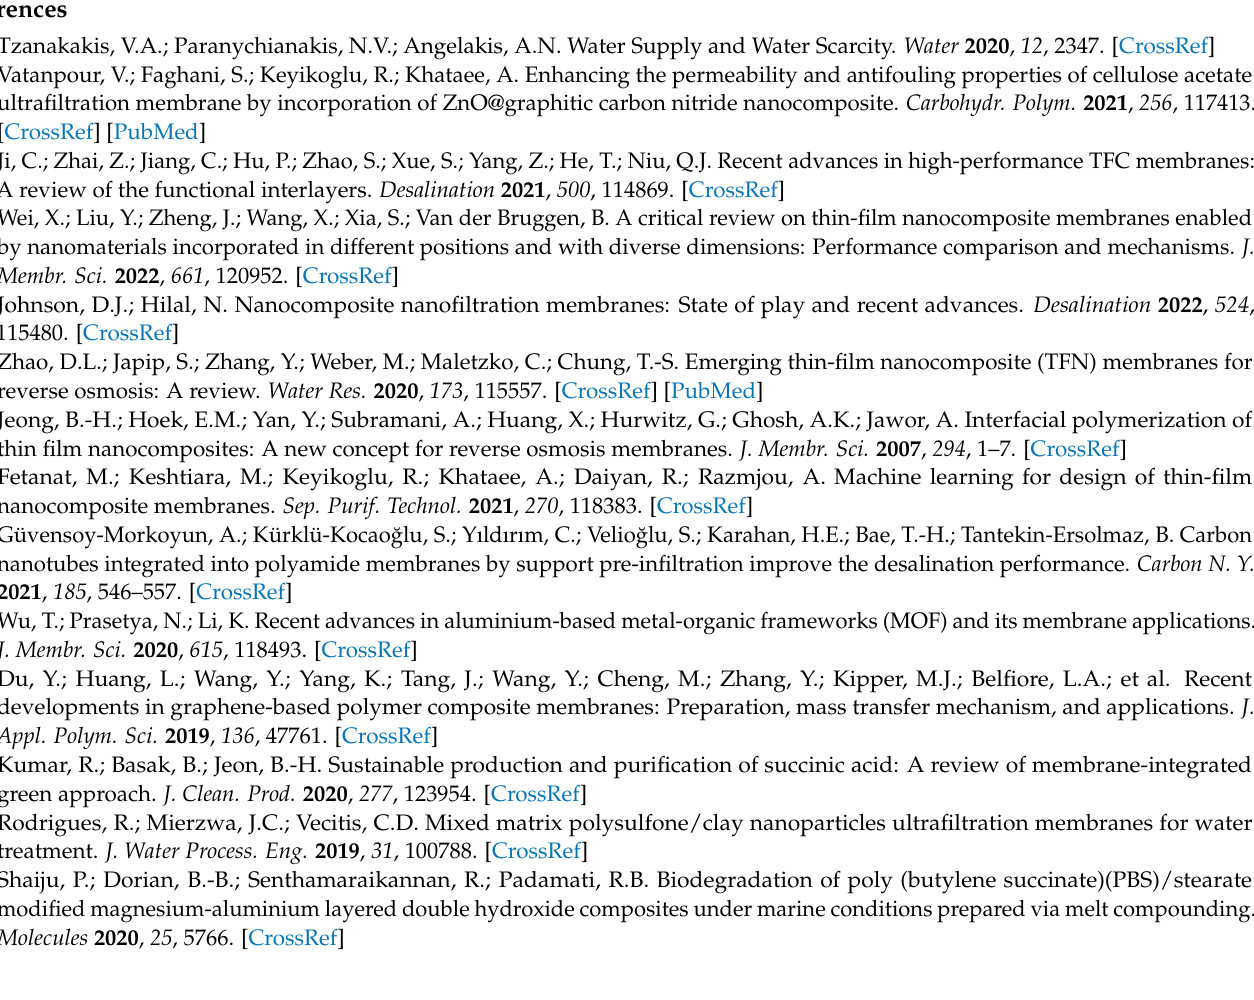
Table S2: Rejection values of the fabricated membrane; and Table S3: t -test results for comparing TFC and TFN 3